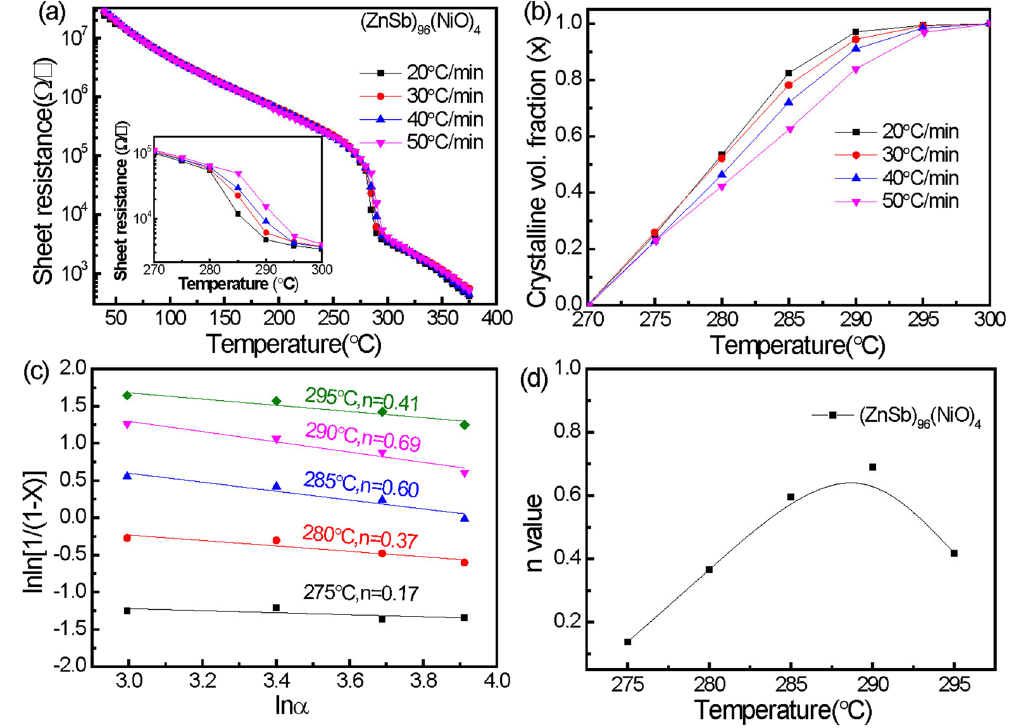
Figure 8. Results taken from (ZnSb) 96 (NiO) 4 film using the of ( a ) R–T curves at different heating rates, ( b ) curves showing fraction of crystallization at different heating rates, ( c ) Ozawa’s plot, and ( d ) temperature- dependent kinetic